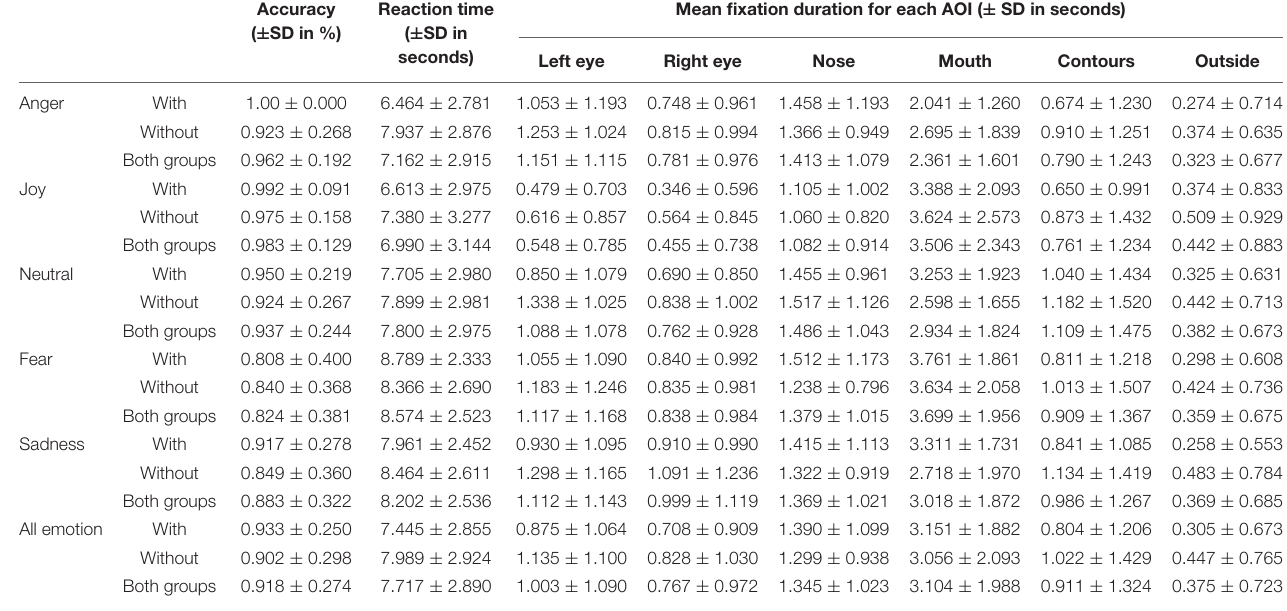
TABLE 2 | Response accuracy, reaction time, and mean fixation duration on the six AOI of children with ASD according to their group (i.e., with a service dog, without a service dog, and both groups) and to the displayed facial expression of the avatars. Mean fixation duration for each AOI ( ± SD in seconds) Accuracy ( ± SD in %) seconds)